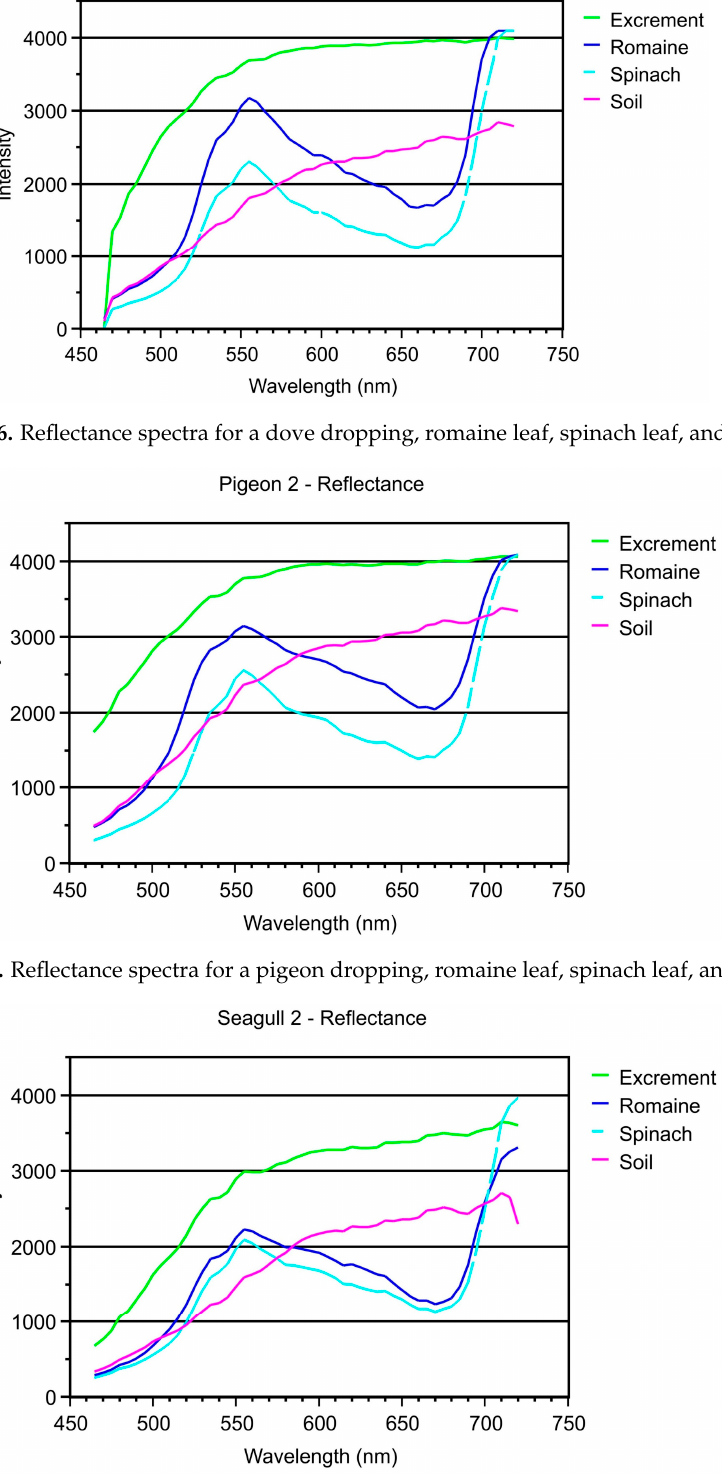
Figure 8. Reflectance spectra for a gull dropping, romaine leaf, spinach leaf, and soil.